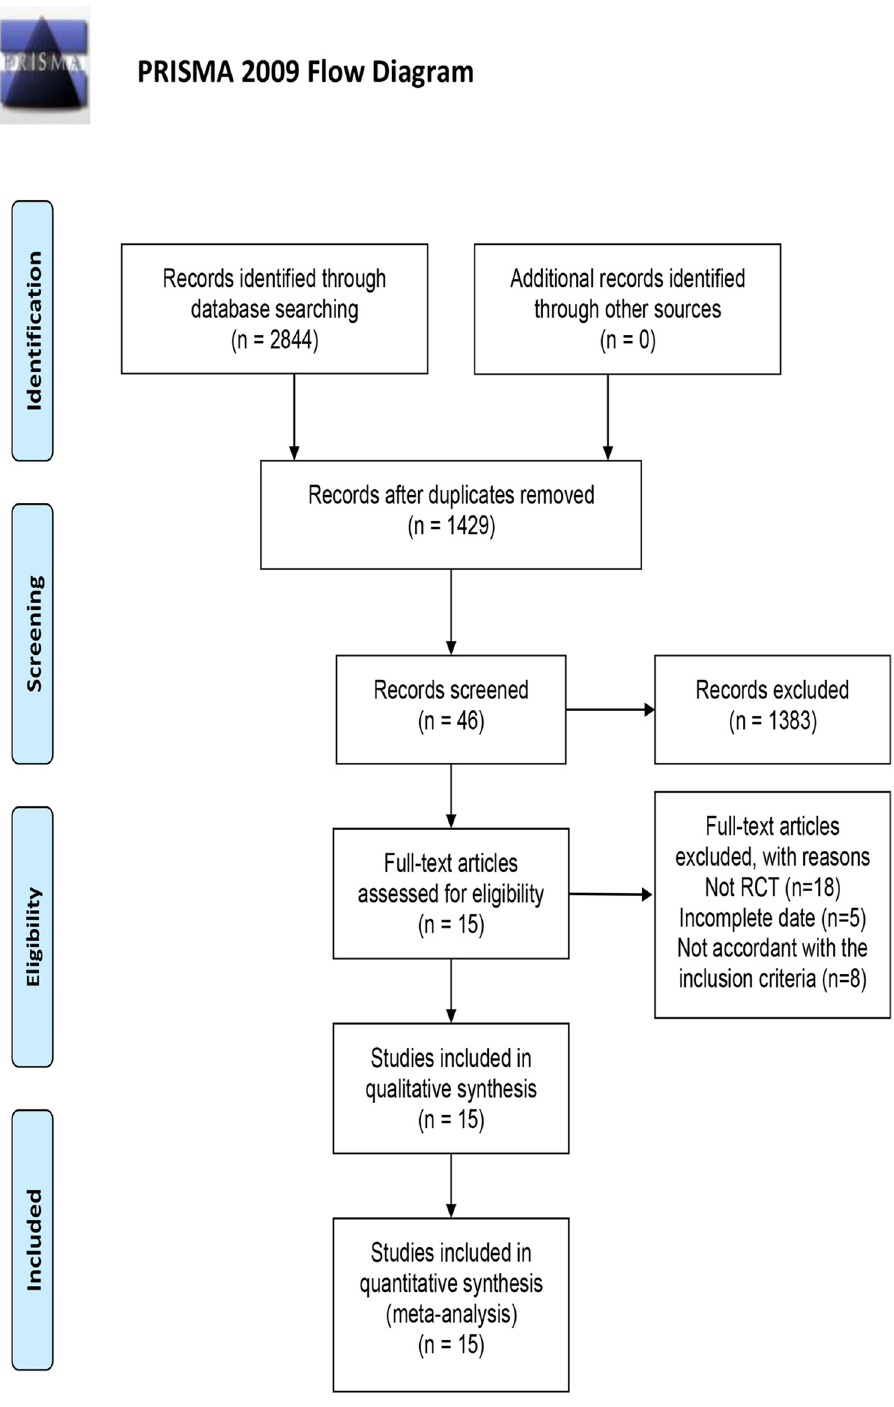
Fig 1. Flow chart of study